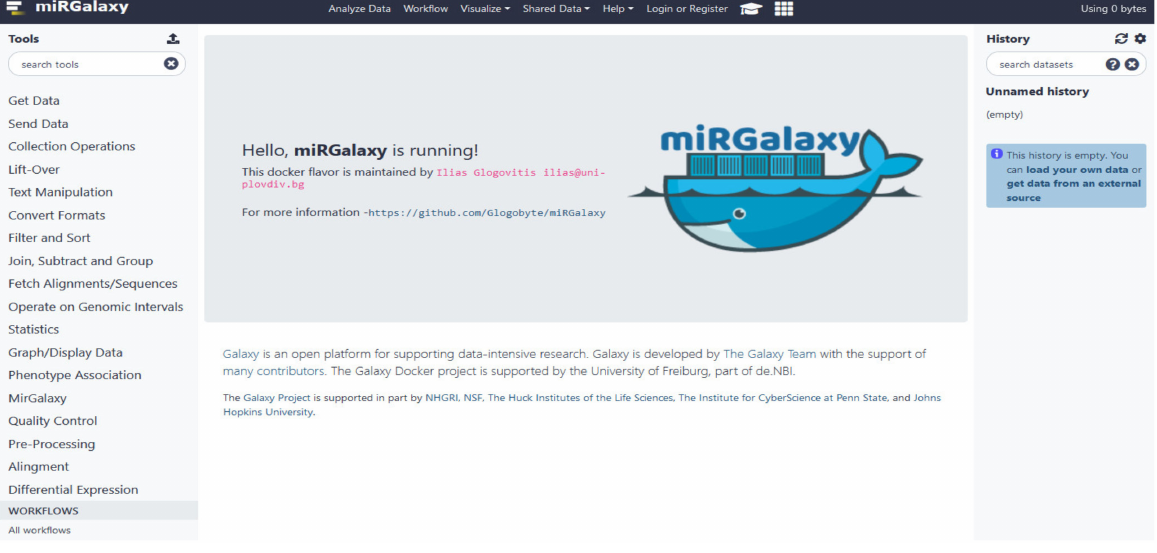
Figure 4. miRGalaxy GUI. The miRGalaxy workflow can be accessed via the top menu